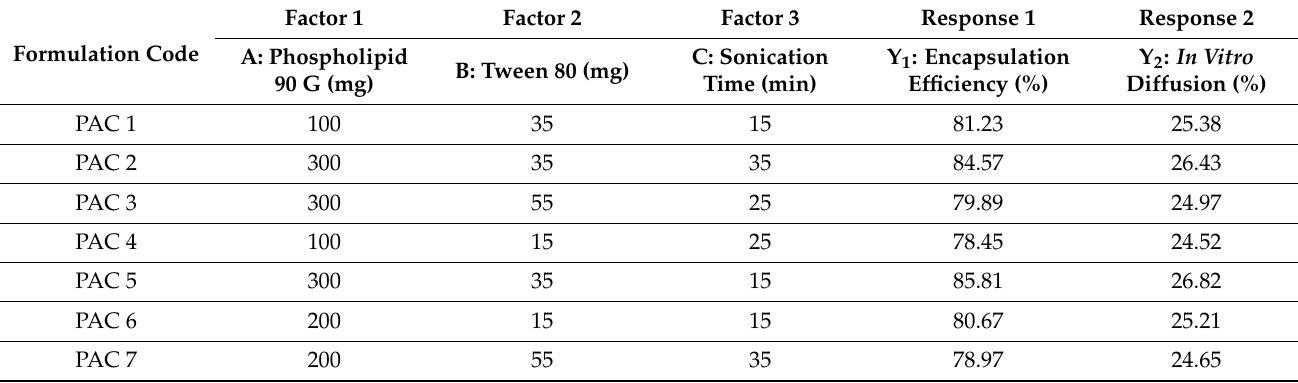
Table 2. Factors and responses for all the